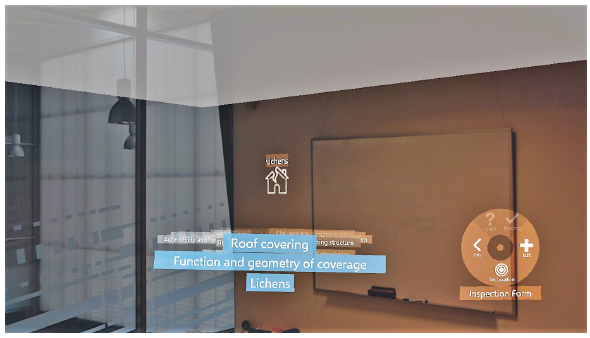
Figure 6. Annotating the damage Lichens to the wall.